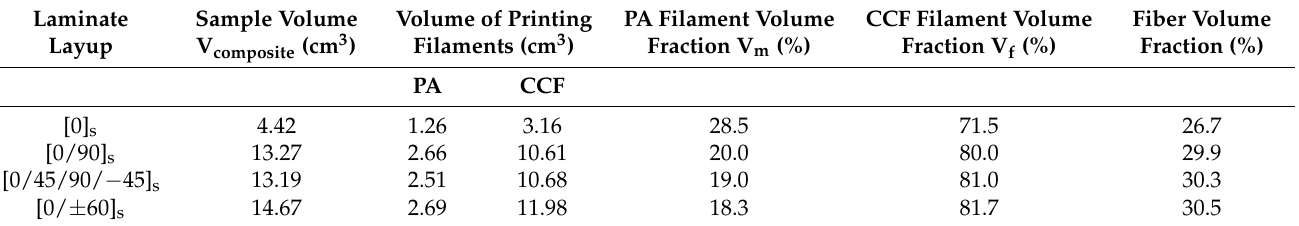
Table 2. Printing volumes and volume fractions of PA and CCF filaments regions in the CCF/PA composites obtained from Eiger software and Equations (1) and (2). The content of carbon fibers for each layup is also